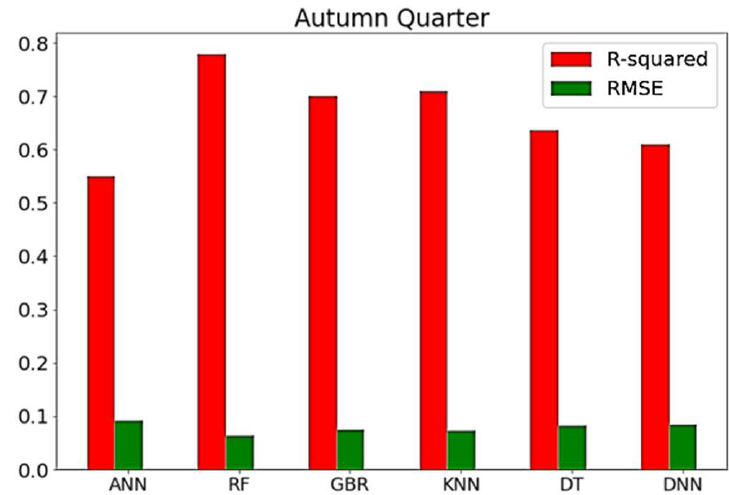
Figure 6. R 2 and RMSE metrics for the ML algorithms autumn data set.